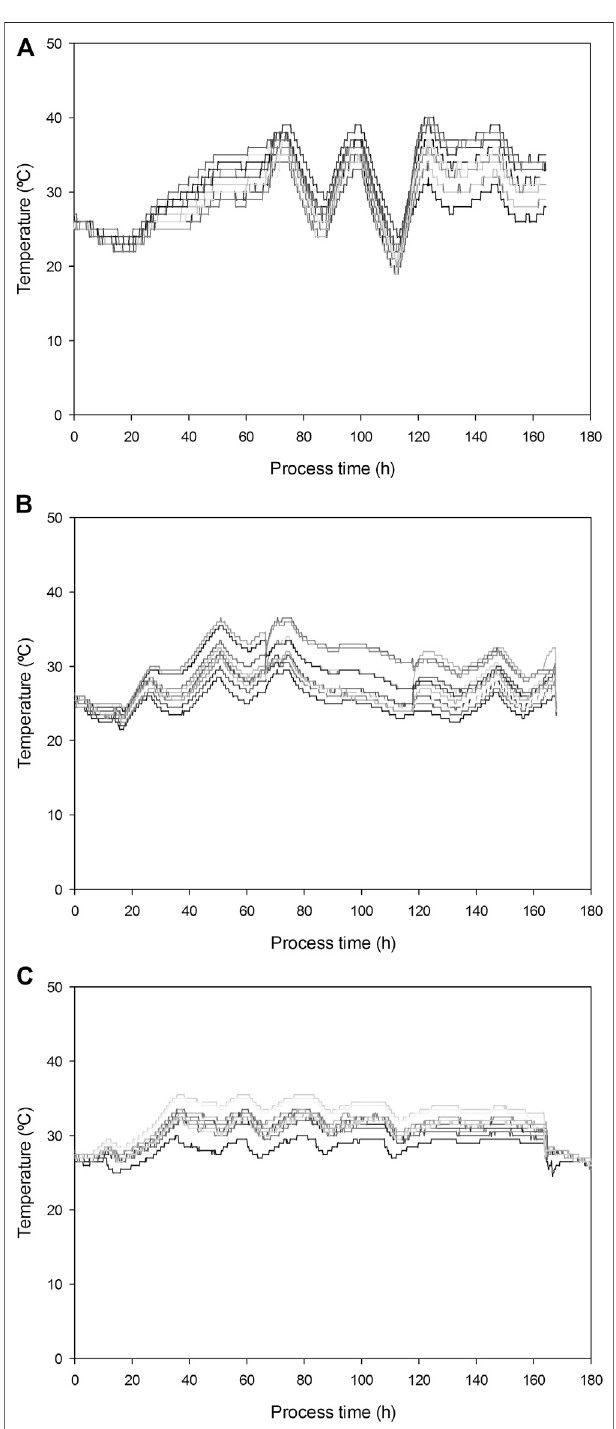
FIGURE 2 | Temperature gradients measured in 13 different points for R22 replicates (A) 1; (B) 2; and (C) 3.